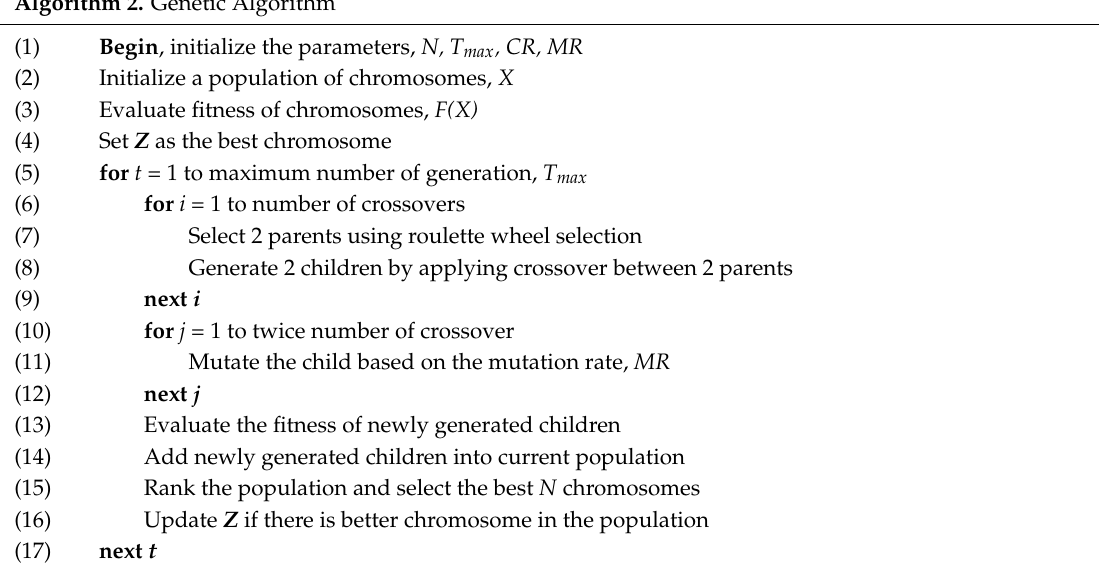
Algorithm 2. Genetic